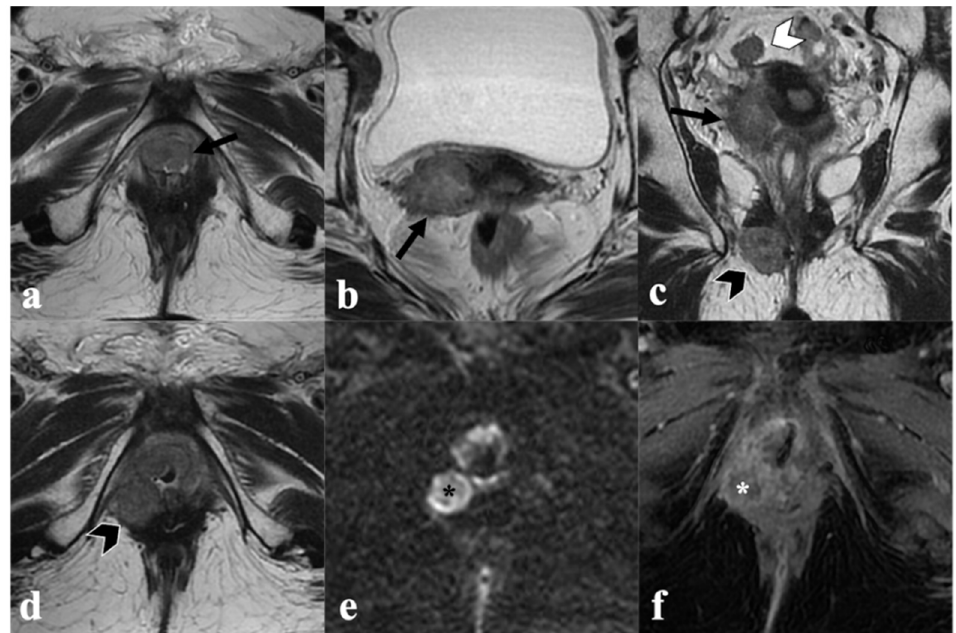
Figure 6. Locally advanced recurrence with satellite nodules. A 66-year-old patient previously treated with excisional biopsy and RT for squamous cell carcinoma of the right labium minus, presenting 3 years later with multiple solid pelvic nodules of intermediate T2 signal intensity, the largest in the lower III of vagina (( a , d )—black arrow), attached to the right lateral uterine wall (( b , c )—black arrow), in pelvic peritoneum (( c )—white arrowhead) and in the ischio-anal fossa (( c , d )—black arrowhead). Satellite nodules also show diffusion restriction (( e )—black star key) and peripheral enhancement (( f )—white star key).